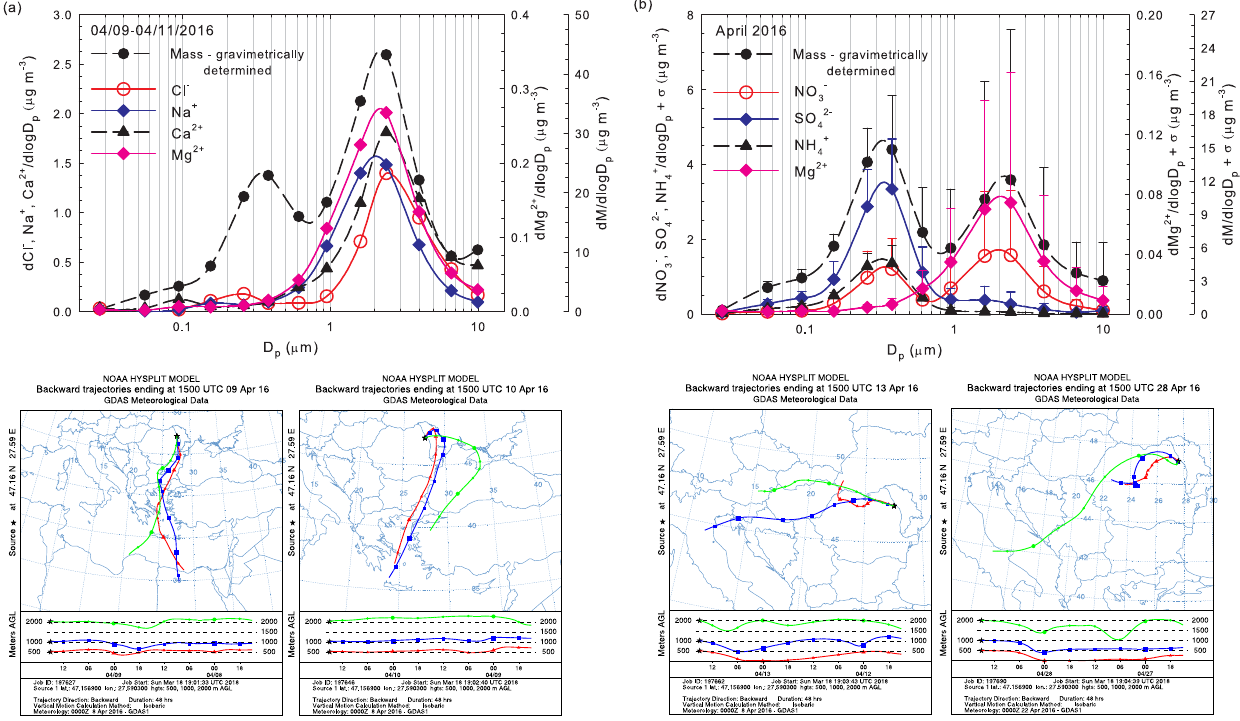
Figure 10. Evidence of long-range transport contributions from Saharan dust within the size distribution of particulate Na + , Ca 2 + , Mg 2 + , Cl − ions, and aerosol mass (a) and of air mass buoyancy phenomena within the size distribution of particulate NH + ions, and aerosol mass (b)